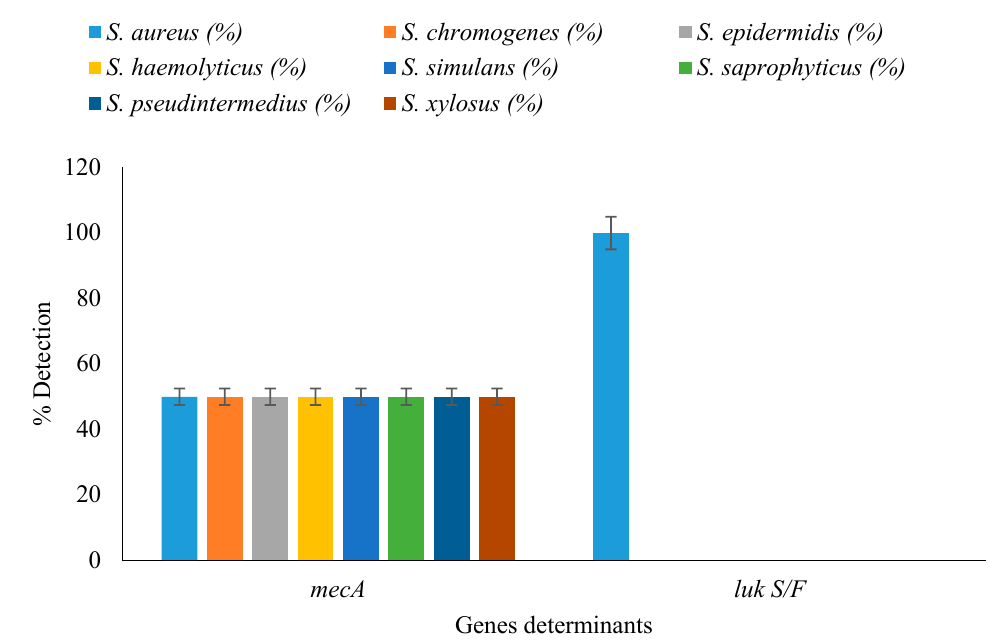
Figure 2. Detection of resistance and virulence genes in staphylococcal isolates from nasal and milk samples.